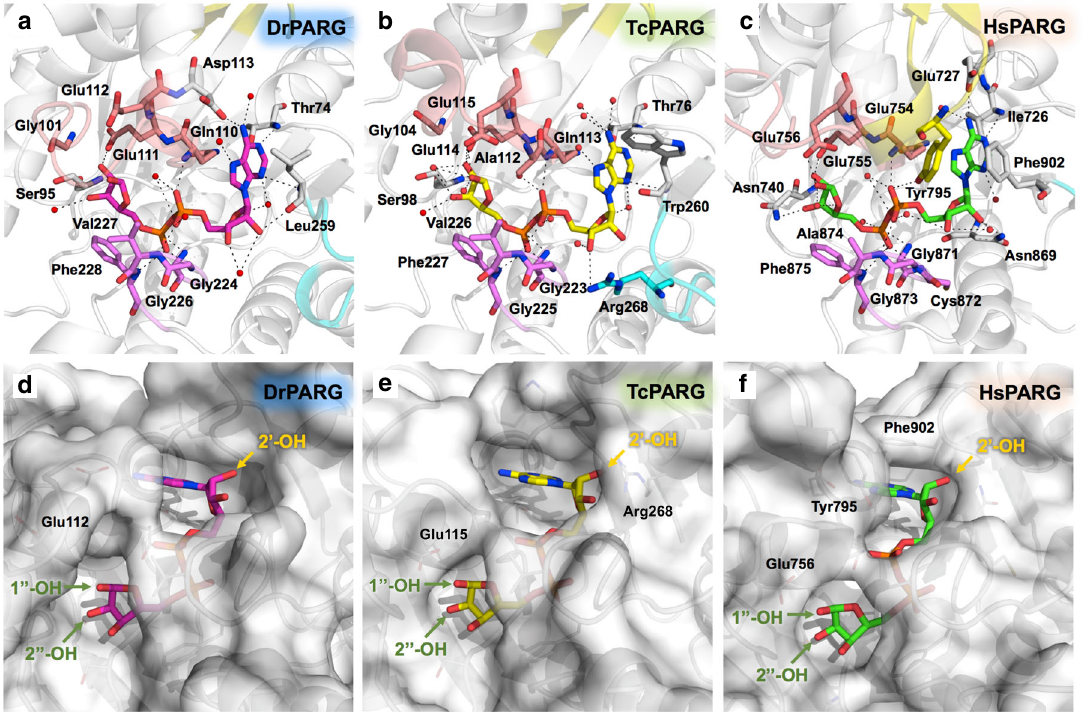
Fig. 2 Detailed view of the ADP-ribose binding pocket of DrPARG. A detailed comparison of interactions within ADP-ribose binding pocket of PARG structures from a Deinococcus radiodurans (DrPARG), b Thermomonospora curvata (TcPARG), and c Homo sapiens (HsPARG). Proteins are represented as cartoon diagram with key residues and ADP-ribose shown as sticks. Carbons of ADP-ribose are colored individually among the three structures. Carbons of the catalytic loop, diphosphate-binding loop, tyrosine clasp, and ribose cap are colored salmon, purple, yellow, and cyan, respectively. Oxygen, nitrogen, and phosphorus are colored red, blue, and orange, respectively. Crystallized waters are shown as red spheres. Hydrogen bonds are represented as dashed lines. Solvent accessibility of bound ADP-ribose in d DrPARG, e TcPARG, and f HsPARG. ADP-ribose is shown as sticks with carbons in the same colors as with panel a , b , and c . Selected residues are labeled. Ribose hydroxyls with potential poly-ADP-ribose (PAR) linkage points are labeled and indicated by